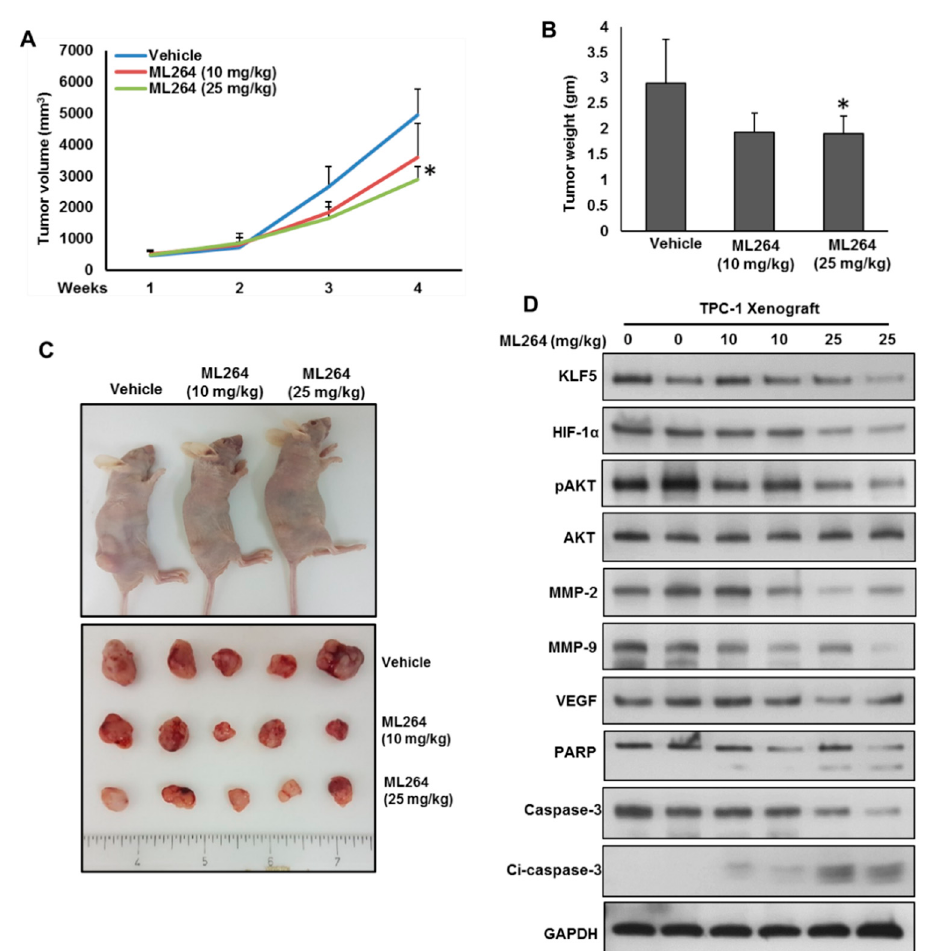
Figure 6. Downregulation of KLF5 inhibited PTC cell growth in vivo. TPC-1 cells were subcutaneously injected into the flanks of 6-week old nude mice (4 × 10 6 cells per mouse). After tumors grew to about 100 mm 3 , mice were treated intraperitoneally with indicated dose of ML264, twice a week for 30 days. ( A ) The volume of each tumor was measured every week. The average (n = 6) tumor volume in each group of mice was calculated. ( B ) After four weeks treatment, mice were sacrificed and mean tumor weight ( ± SD) was calculated in each group, * p < 0.05. ( C ) Representative tumor images of each group of mice. ( D ) Tissue lysates from tumors were immuno-blotted with antibodies against KLF5, HIF-1 α , pAKT, AKT, MMP-2, MMP-9, VEGF, PARP, caspase-3, cleaved caspase-3 and GAPDH.